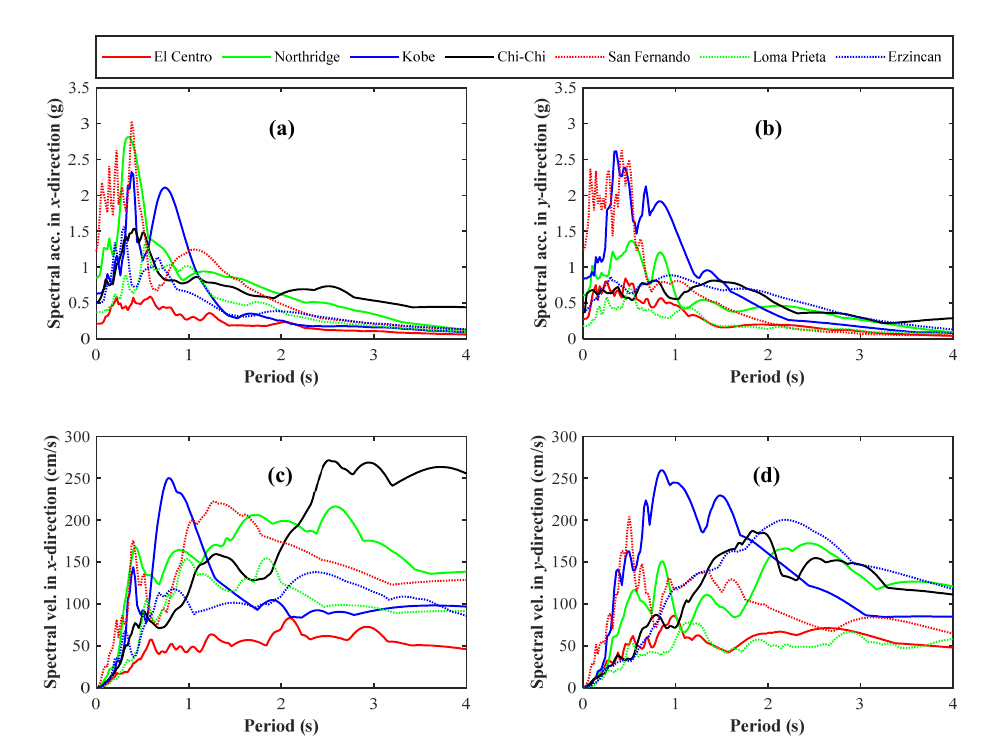
Figure 10. Spectral acceleration, ( a ) and ( b ), and spectral velocity, ( c ) and ( d ), of the selected earthquakes in two directions.